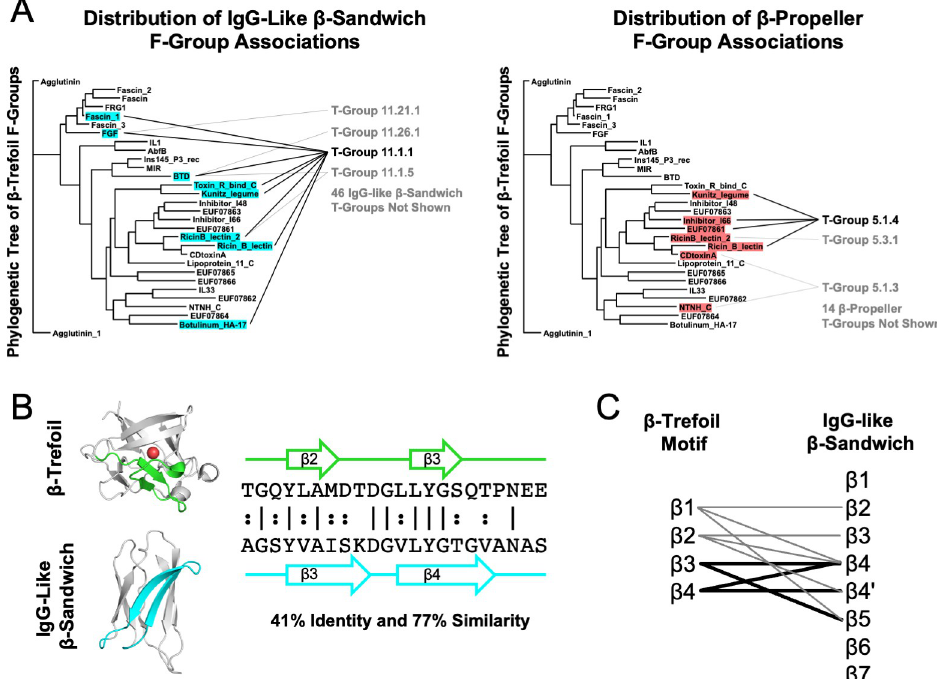
Fig 2. The IgG-like β -sandwich as a candidate progenitor of the β -trefoil. A . The distribution of IgG-Like β - sandwich and β -propeller bridging themes across the β -trefoil phylogenetic tree. Β -trefoil families with a bridging theme are highlighted following the color scheme in Fig 1 . The specific IgG-like β -sandwich or β -propeller T-groups ( i . e ., the group of F-groups) that are associated with the β -trefoil family are noted. The IgG-like β -sandwich is not only associated with the most β -trefoil families, these families are well-distributed across the β -trefoil evolutionary tree (more so than the β -propeller, for example). And, while the bridging themes of other protein lineages span multiple T- groups, all of the β -trefoil families associated with the IgG-like β -sandwich also have at least one bridging theme to the same T-group, 11.1.1, which is just one out of 50 T-groups associated with this X-group (though it is the also largest and most diverse one). The β -trefoil phylogenetic tree was adapted from ECOD (http://prodata.swmed.edu/ecod/ complete/famtree?tid=6.1.1) with permission. B . An example bridging theme between a β -trefoil and an IgG-like β - sandwich, ECOD domains e1rg8A1 and e4rbmA3, respectively. By aligning the themes and denoting the positions of the β -strands, strand associations can be generated. Structure figures were rendered in PyMOL (pymol.org). C . Strand associations between the β -trefoil and the IgG-like β -sandwich T-Group 11.1.1 for themes with an E-value < 1x10 -4 that have a structure model for both sequence segments. Although localized to β 2- β 5 in the IgG-like β -sandwich structure, the specific strand associations are unclear, perhaps due to rearrangement events in either the β -trefoil and/ or IgG-like β -sandwich lineages. Nevertheless, all four β -strands in the β -trefoil repetitive motif have some association to IgG-like β -sandwich. Thin lines correspond to a single bridging theme whereas thick lines correspond to two